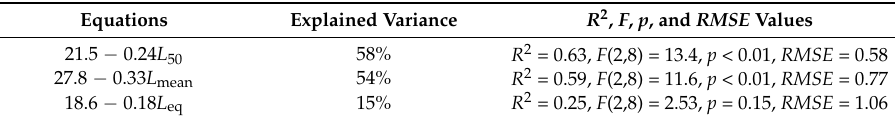
Table 5. Different models to estimate global pleasantness from physical measurements.